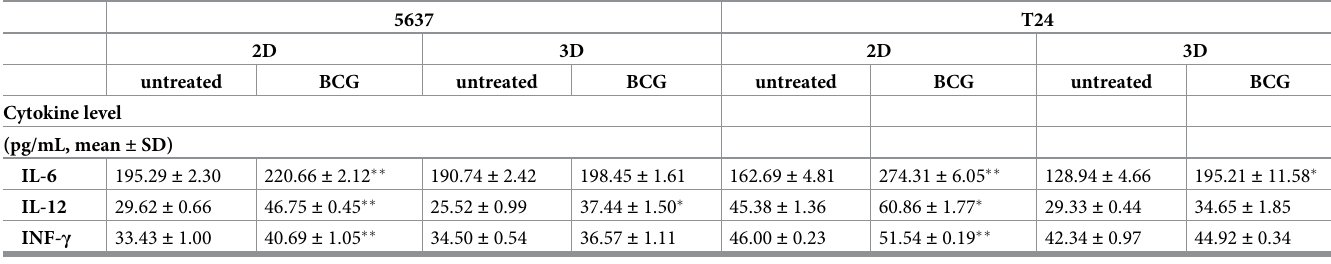
Table 1. The concentrations of cytokines in 2D and 3D bladder cancer cell environments after BCG